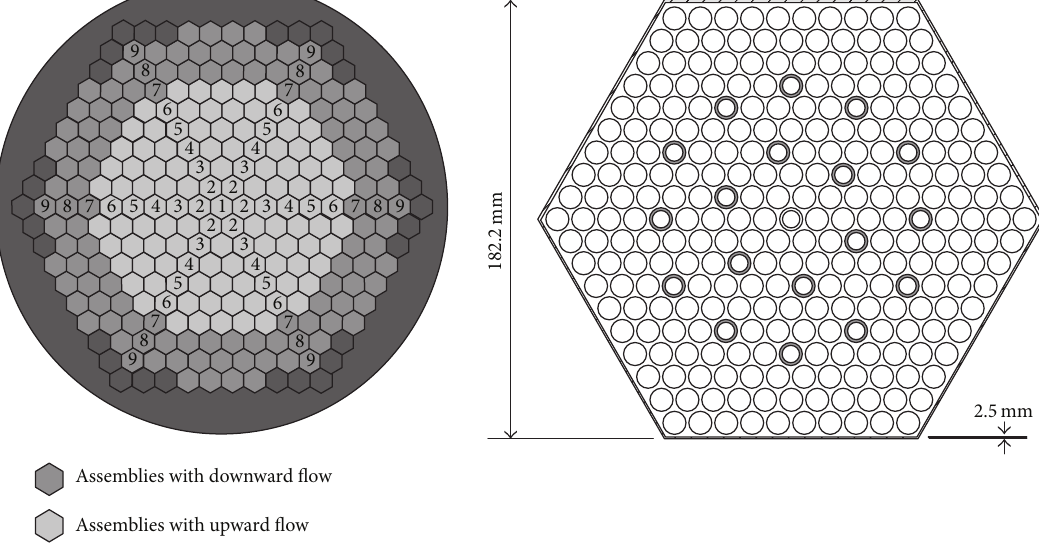
Figure 2: Conceptual design of SCFR core and assembly.